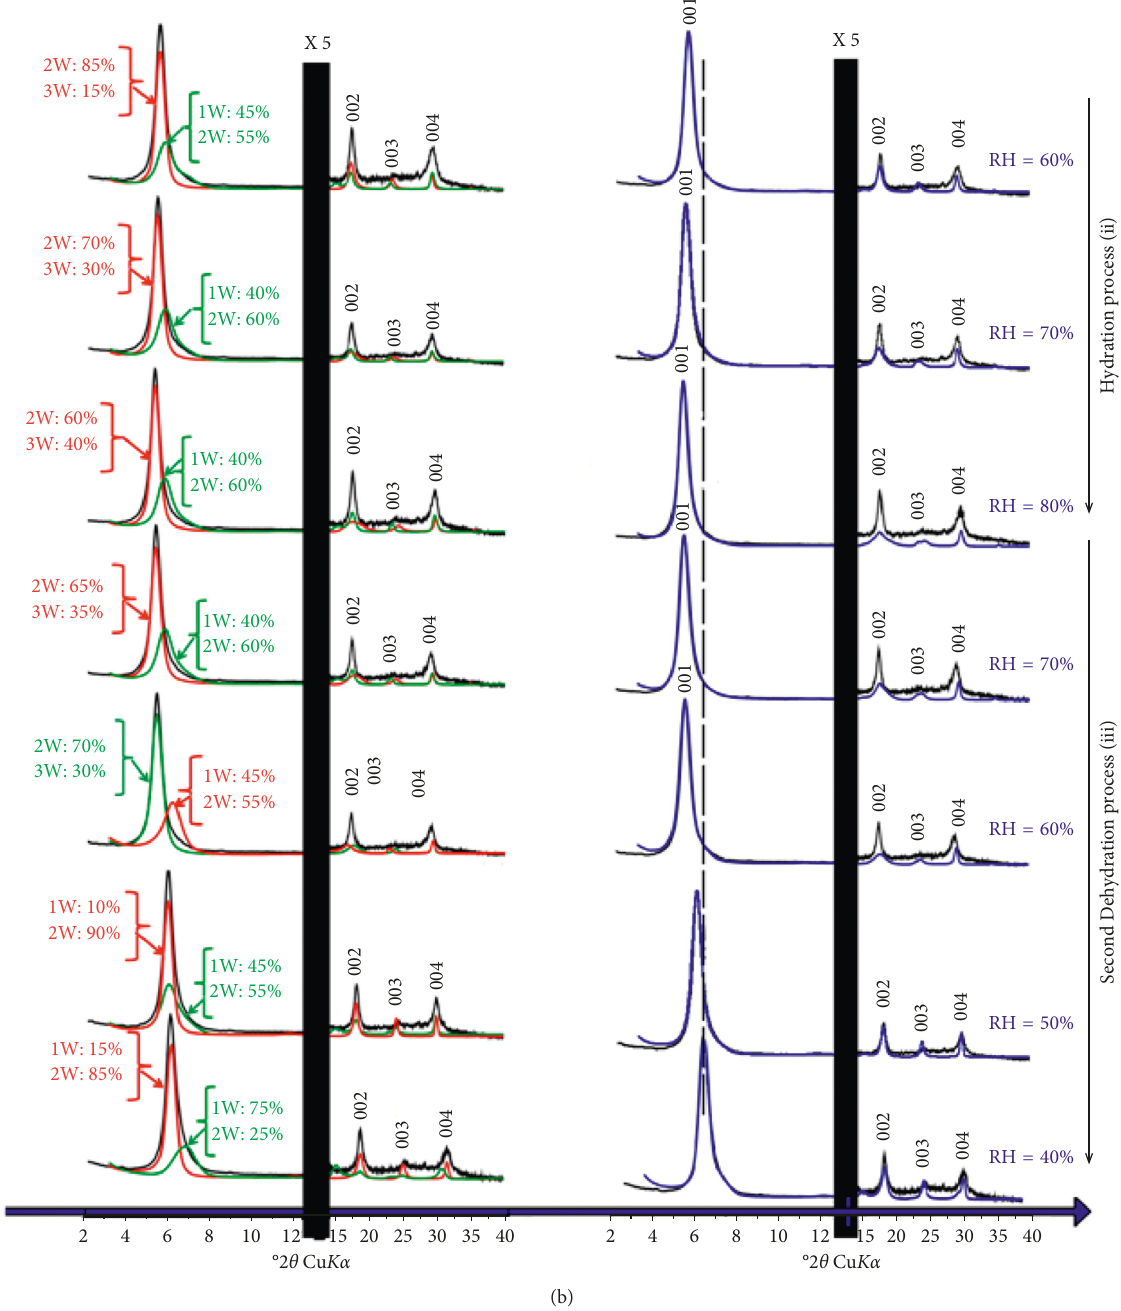
Figure 5: Best agreement between experimental (black line) and calculated (blue line) XRD patterns obtained using the respective contributions of the various MLSs (red and green line) in the case of the second